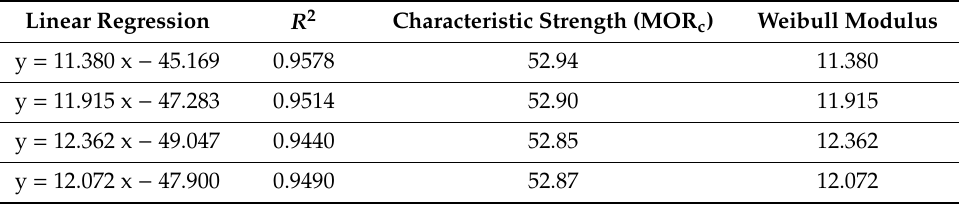
Table 5. Values obtained from the Weibull